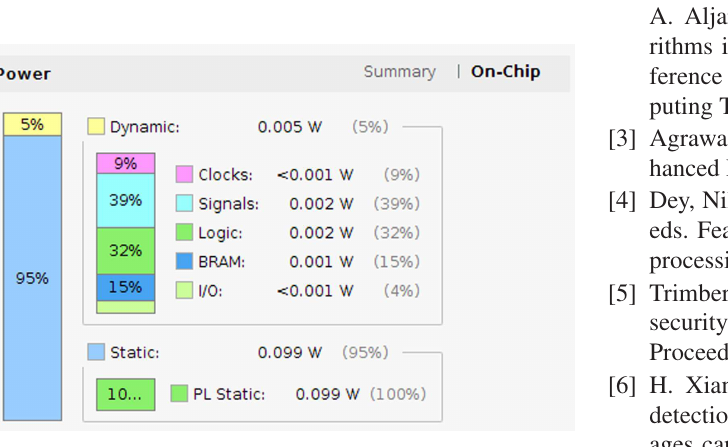
Figure 12. Power Utilization Summary.